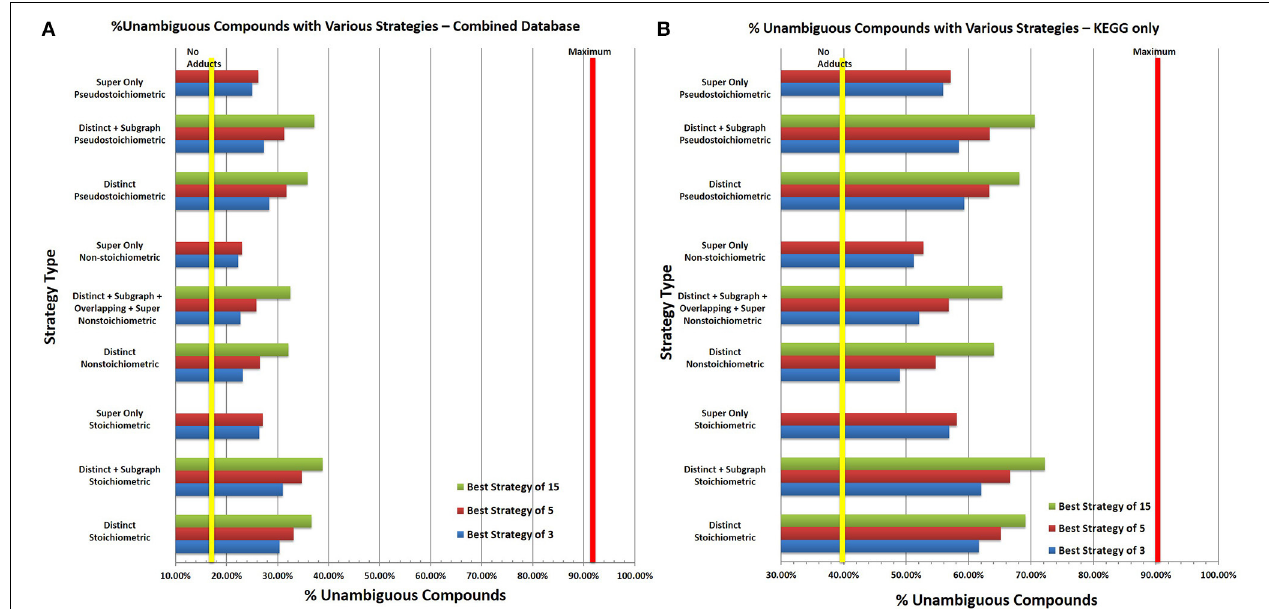
FIGURE 13 | Percent of Unambigiuous Compounds with Selected CS-Tagging Strategies. (A) In general, using more adducts improves the disambiguation of compounds for all strategies. For pseudostoichiometric and stoichiometric strategies, the difference seen in utilizing 15 functional groups compared to 5 is roughly equal to the difference in performance seen with 5 and 3 functional groups indicating that multiplexing multiple groups offers increased performance but with diminishing returns. The yellow vertical line represents the percent of unambiguous formulae without adduct formation, the red line represents the percent of formulae without stereoisomers, which cannot be disambiguated with CS-Tagging alone due to stereoisomerism. In all three stoichiometric environments, very good performance is achieved by detecting distinct instances of the functional groups alone. The ability to detect subgraph or overlapping instances of each functional group offers only marginal improvements in performance. Super functional group only strategies consistently provided the worst performance. Stoichiometric tagging offers the maximum percent of disambiguation; however, it will be difficult to ensure consistent results experimentally. Pseudostoichiometric adduct formation provides performance close to stoichiometric tagging and much greater performance than non-stoichiometric tagging. However, the performance of all the strategies falls short of the theoretical maximum expected from